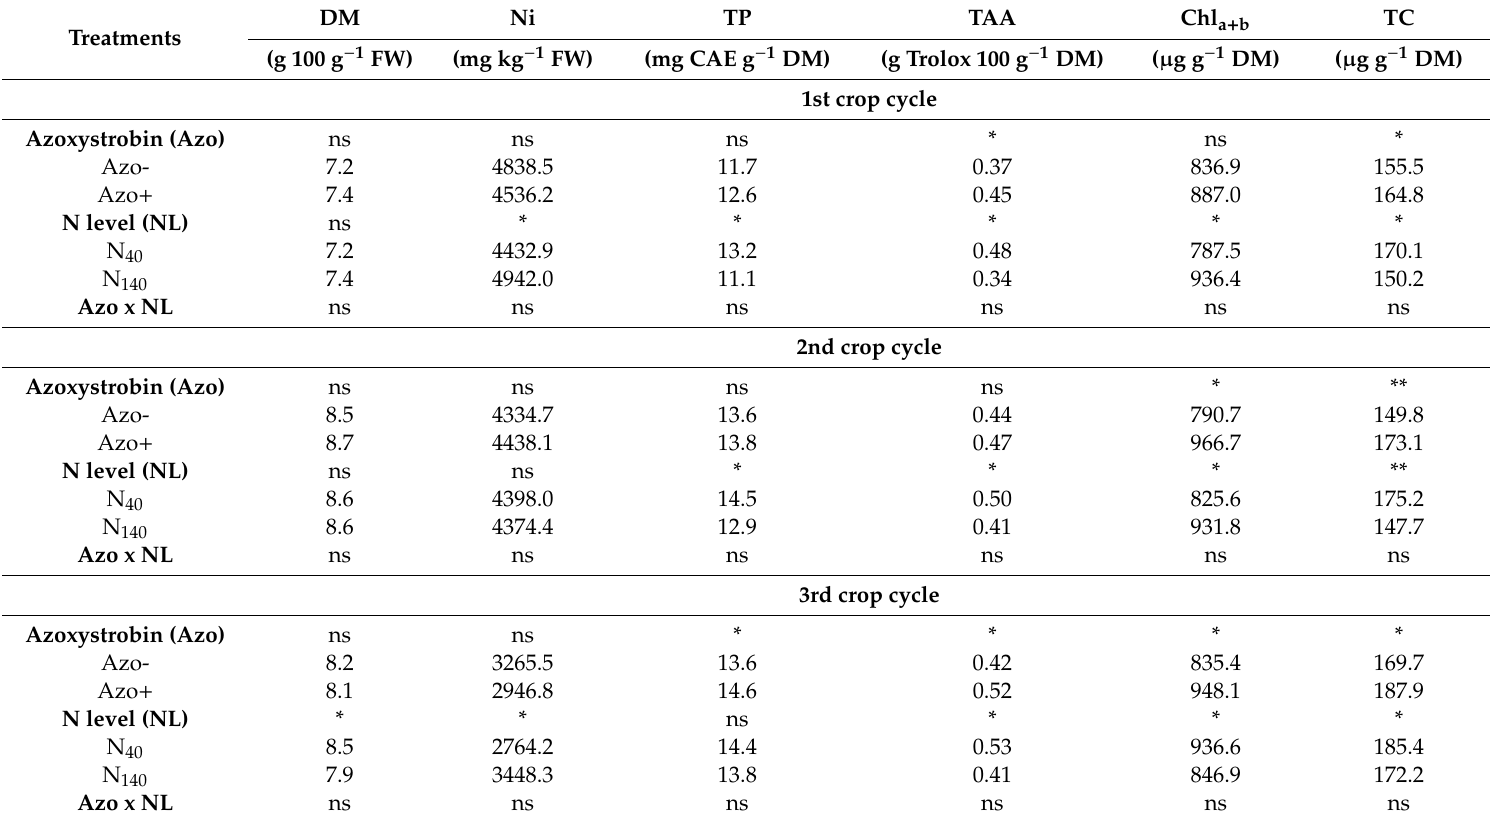
Table 2. E ff ects of the Azoxystrobin (Azo) application and N level (NL) on leaf dry matter (DM), nitrate (Ni), total phenols (TP), total antioxidant activity (TAA), total chlorophyll (Chl a + b ), and total carotenoids (TC) of wild rocket in the four crop cycles. Azo − = control without Azoxystrobin, Azo + = with Azoxystrobin; N 40 = 40 kg ha − 1 of N, N 140 = 140 kg ha − 1 of